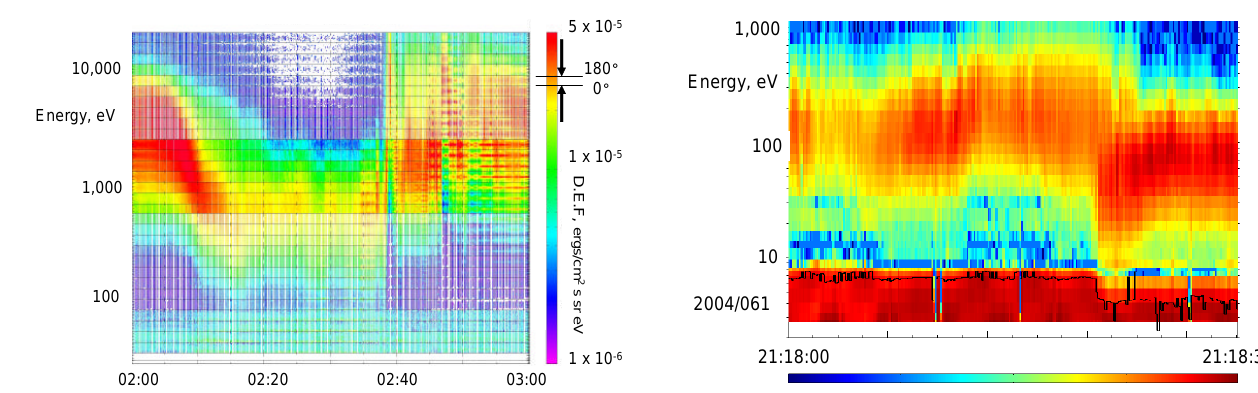
Figure 13. Example of energy-pitch angle-time plot to demonstrate the effectiveness of ground-based pitch angle production (September 03 rd 2004, PEACE data from TC1)